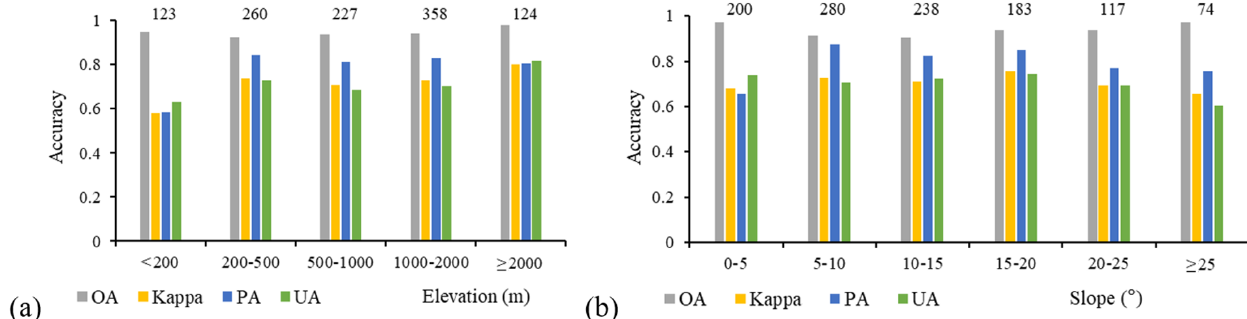
Figure 7. OA, kappa, PA of terrace class, and UA of terrace class for (a) different elevation and (b) different slope. The numbers marked in the figure represent the terrace sample size within the corresponding elevation or slope range. Two test samples not covered by SRTM DEM data were not used in the terrain-related accuracy evaluation.